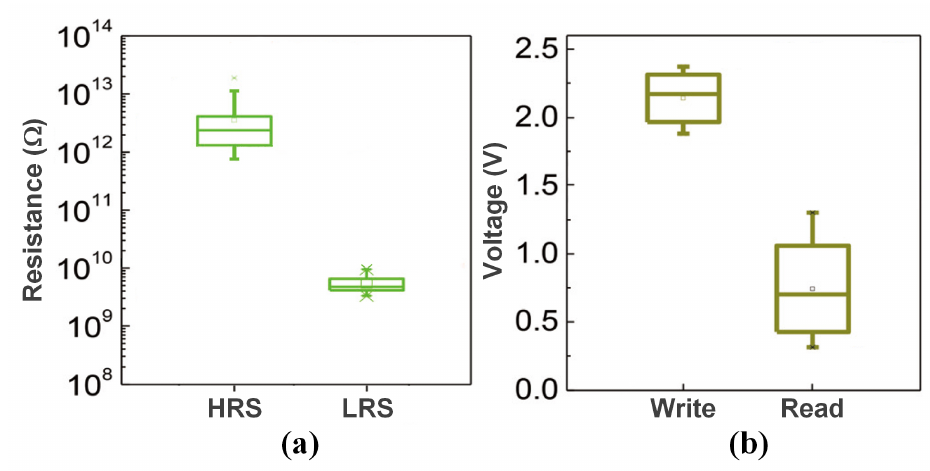
Figure 6. ( a ) Resistance distributions and ( b ) voltage distributions of 50 BNR devices.